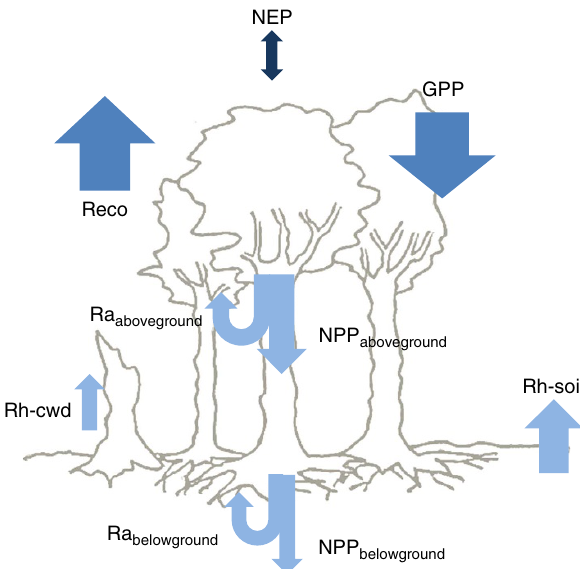
Figure 1 | Schematic representation of the major components of the forest carbon cycle. Ra aboveground and Ra belowground : above- and below- ground autotrophic respiration, respectively (their sum is indicated as Ra); Rh-soil and Rh-cwd: heterotrophic respiration from soil and coarse woody debris, respectively (their sum is indicated as Rh); NPP aboveground and NPP belowground : above- and belowground net primary production, respectively (their sum is indicated as NPP); Reco: ecosystem respiration (Reco ¼ Ra þ Rh); GPP: gross primary production (GPP ¼ NPP þ Ra), and NEP: net ecosystem production (NEP ¼ GPP (cid:2) Reco ¼ NPP (cid:2) Rh). Each flux is associated with an arrow. Arrows pointing down indicate carbon (C) uptake, arrows pointing up indicate C release, whereas the up-down arrow indicates that both C release and C uptake can occur. The dark blue arrow indicates NEP, the mid-blue arrows indicate the primary components of NEP (Reco and GPP), whereas the light blue arrows indicate the components of Reco and